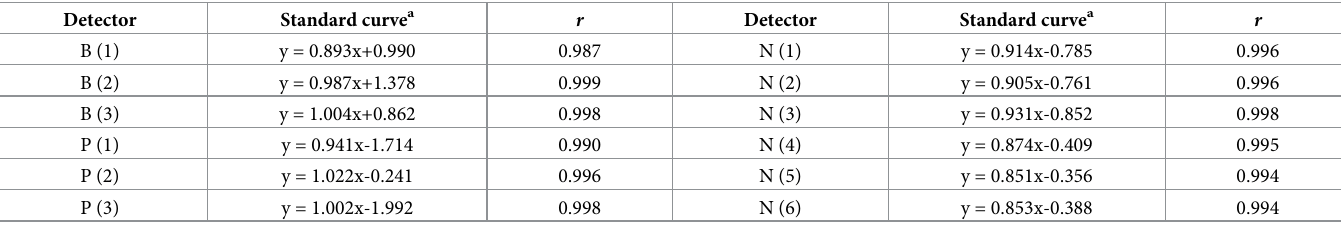
Table 1. The standard curve and linear correlation coefficient ( r) of each detectors. Detector Standard curve